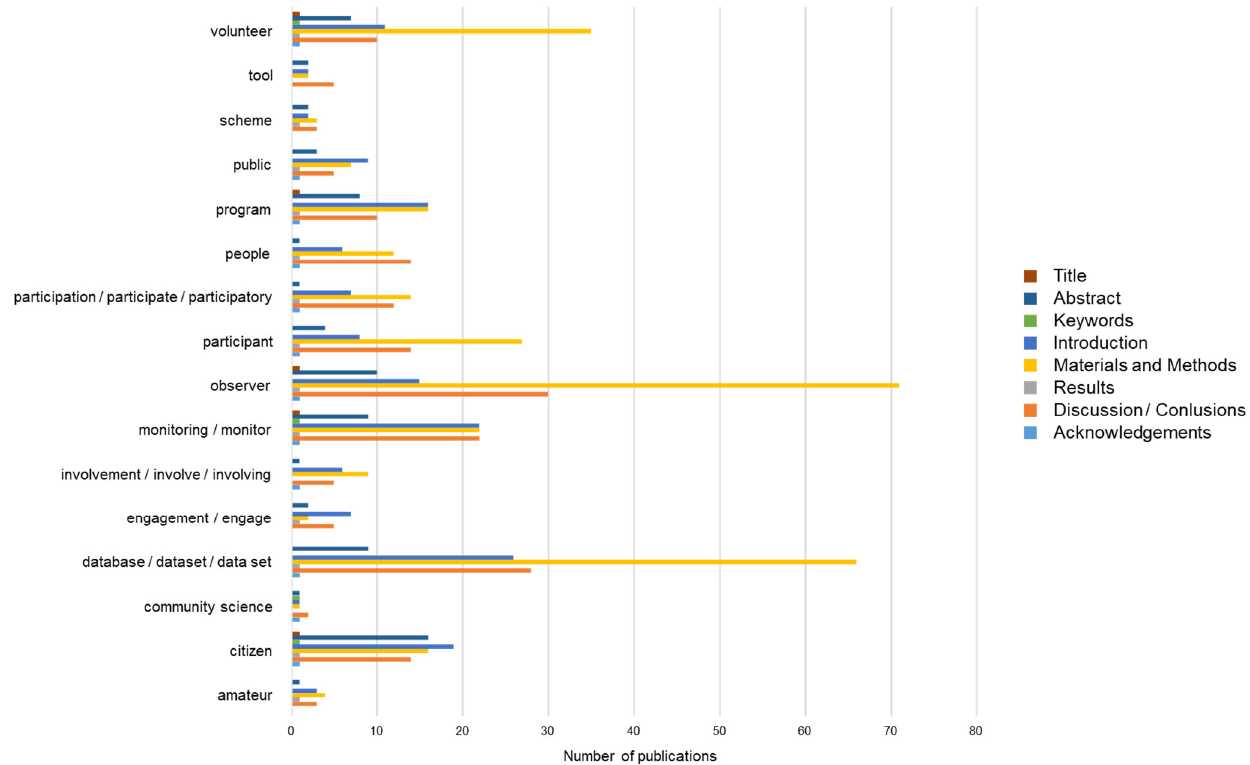
Figure 2. Histogram representing the number of keywords related to CS found in the 149 CBC publications according to their citation section.